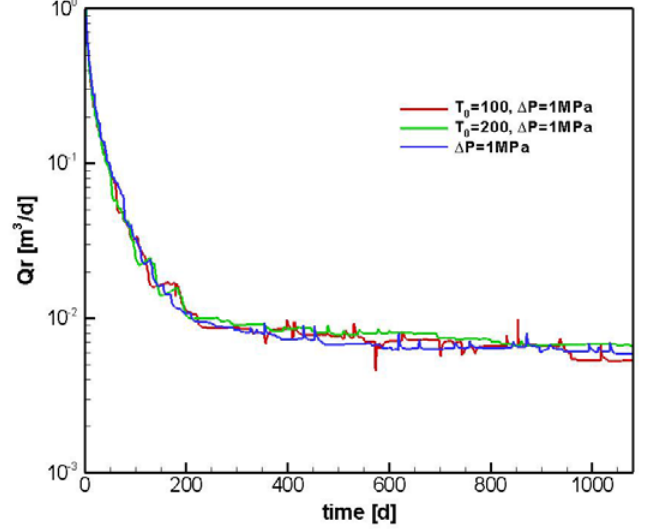
Figure 12. Comparison of gas release rate from hydrate deposit. A 1-MPa depressurization is involved in the three